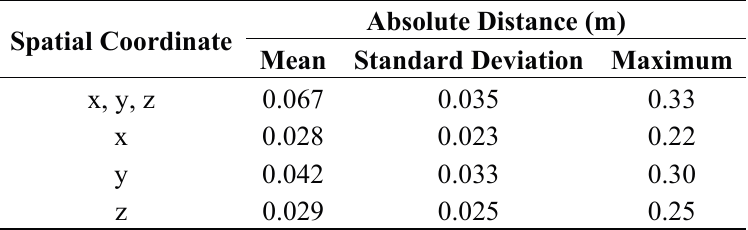
Table 1. Statistics of the absolute distance calculated between SFM photogrammetry and DIY-TLS point cloud datasets for x , y , z spatial coordinates.